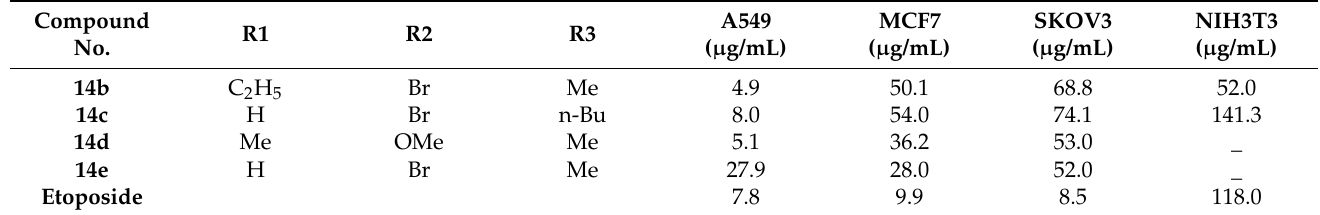
Table 14. In vitro cytotoxic activities of indole-chalcone based hybrid compounds 14 ( b – e ).